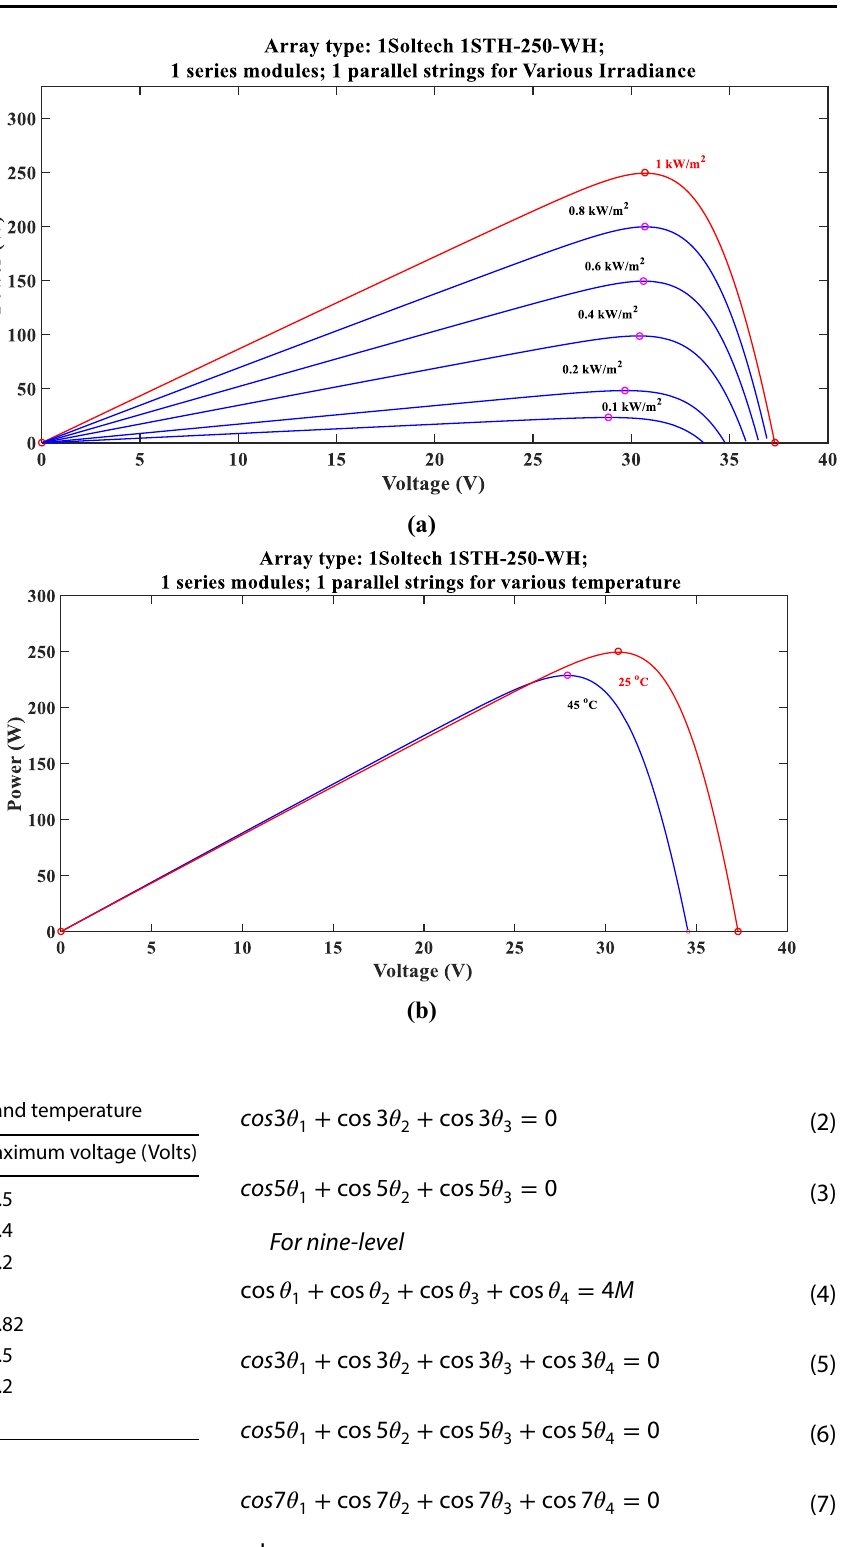
Fig. 4 Solar module PV characteristics for Soltech 1 STH-250 W a various irradiance at 25 °C b various temperature for 1000 W/m2 irradiance